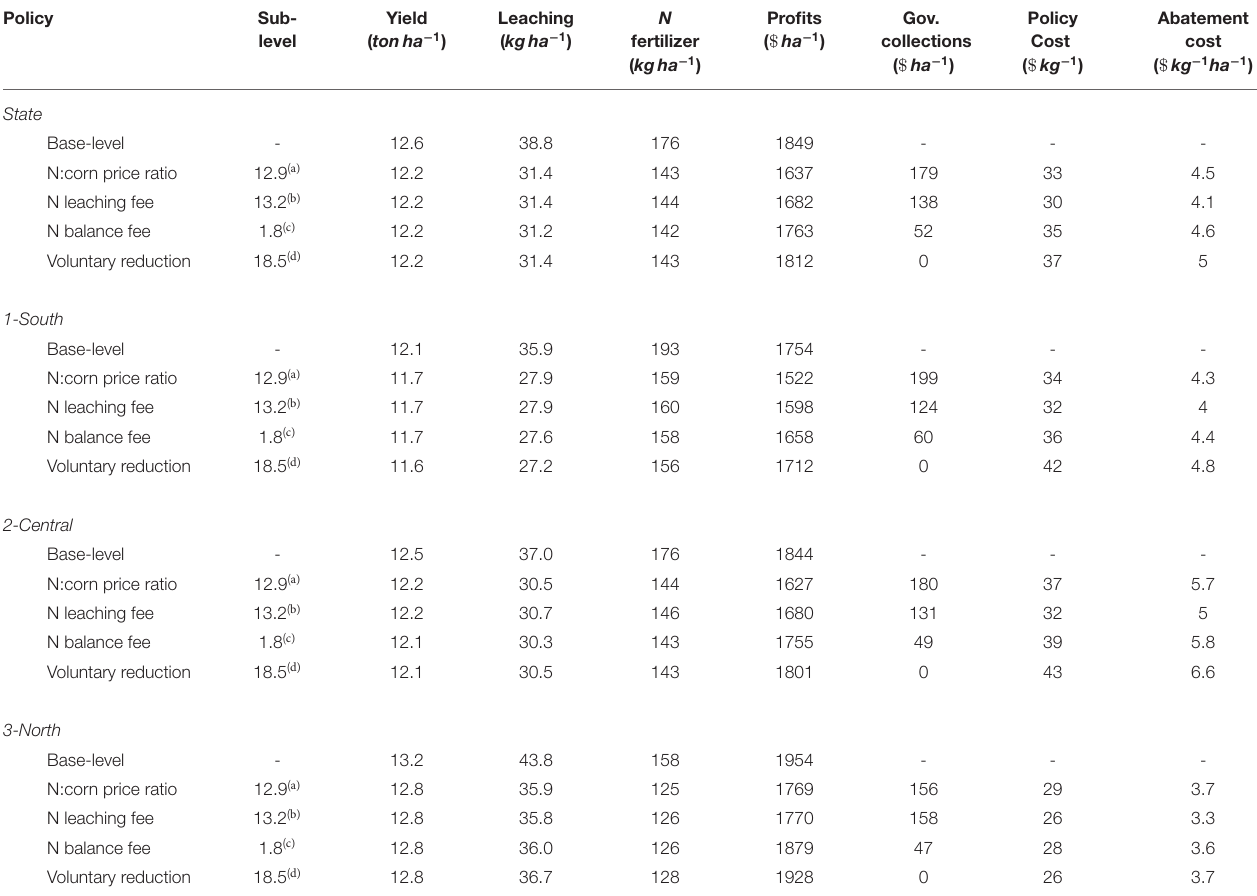
TABLE 1 | Main indicators for the base-level situation and the four